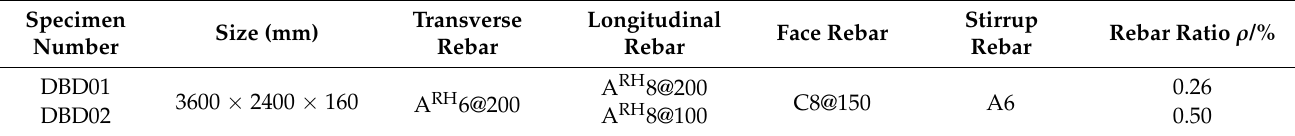
Table 1. Detailed dimensions and reinforcement of sandwich laminated floor